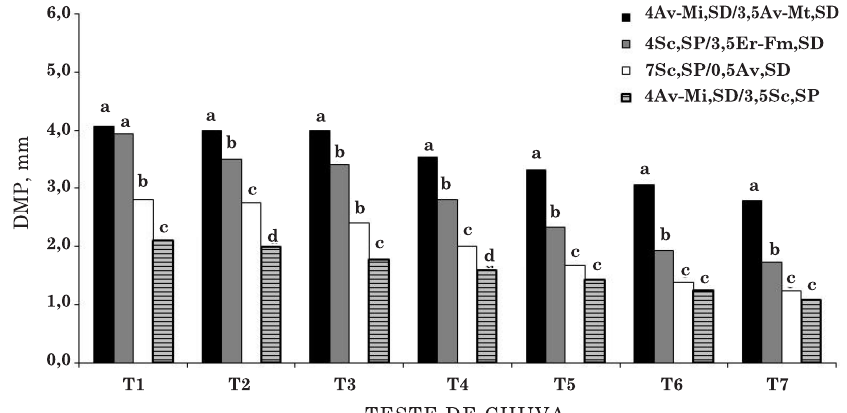
Figura 1. Diâmetro médio ponderado (DMP) dos agregados do solo antes da realização dos testes de erosão com chuva simulada (condição superficial nos testes: T1=solo não mobilizado e completamente coberto; T2=solo não mobilizado e descoberto; T3 a T7=solo sucessivamente mobilizado com grade leve e descoberto) nas sequências culturais estudadas (valores médios de duas repetições por tratamento). Colunas sobrepostas com a mesma letra, no mesmo teste de chuva, não diferem estatisticamente entre si (Duncan, p <